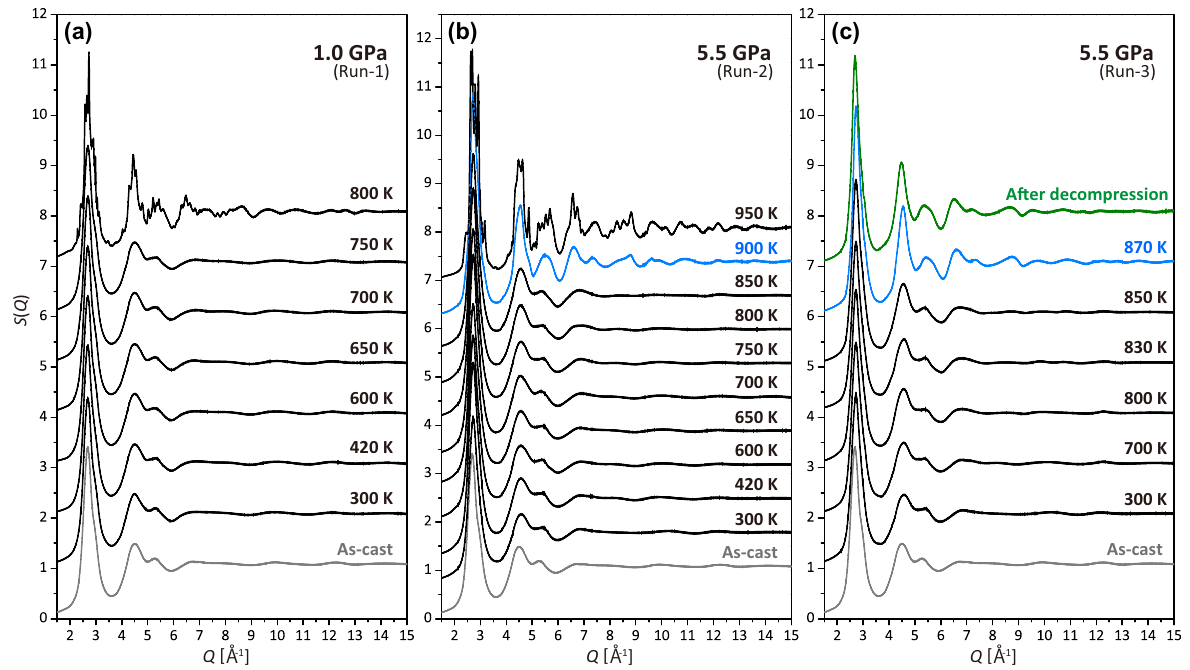
Fig. 2 Structure factors S ( Q ) of Zr 50 Cu 40 Al 10 BMG at high pressures. a S ( Q ) at 1.0 GPa (Run-1). b S ( Q ) at 5.5 GPa up to the temperature where sharp peaks from crystal were observed (Run-2). c S ( Q ) at 5.5 GPa below the temperature where sharp crystal peaks were observed in Run-2 and after decompression (Run-3). Temperature values indicate synthesized temperature conditions. The data are shifted by 1.0 in a and c , and 0.7 in b for